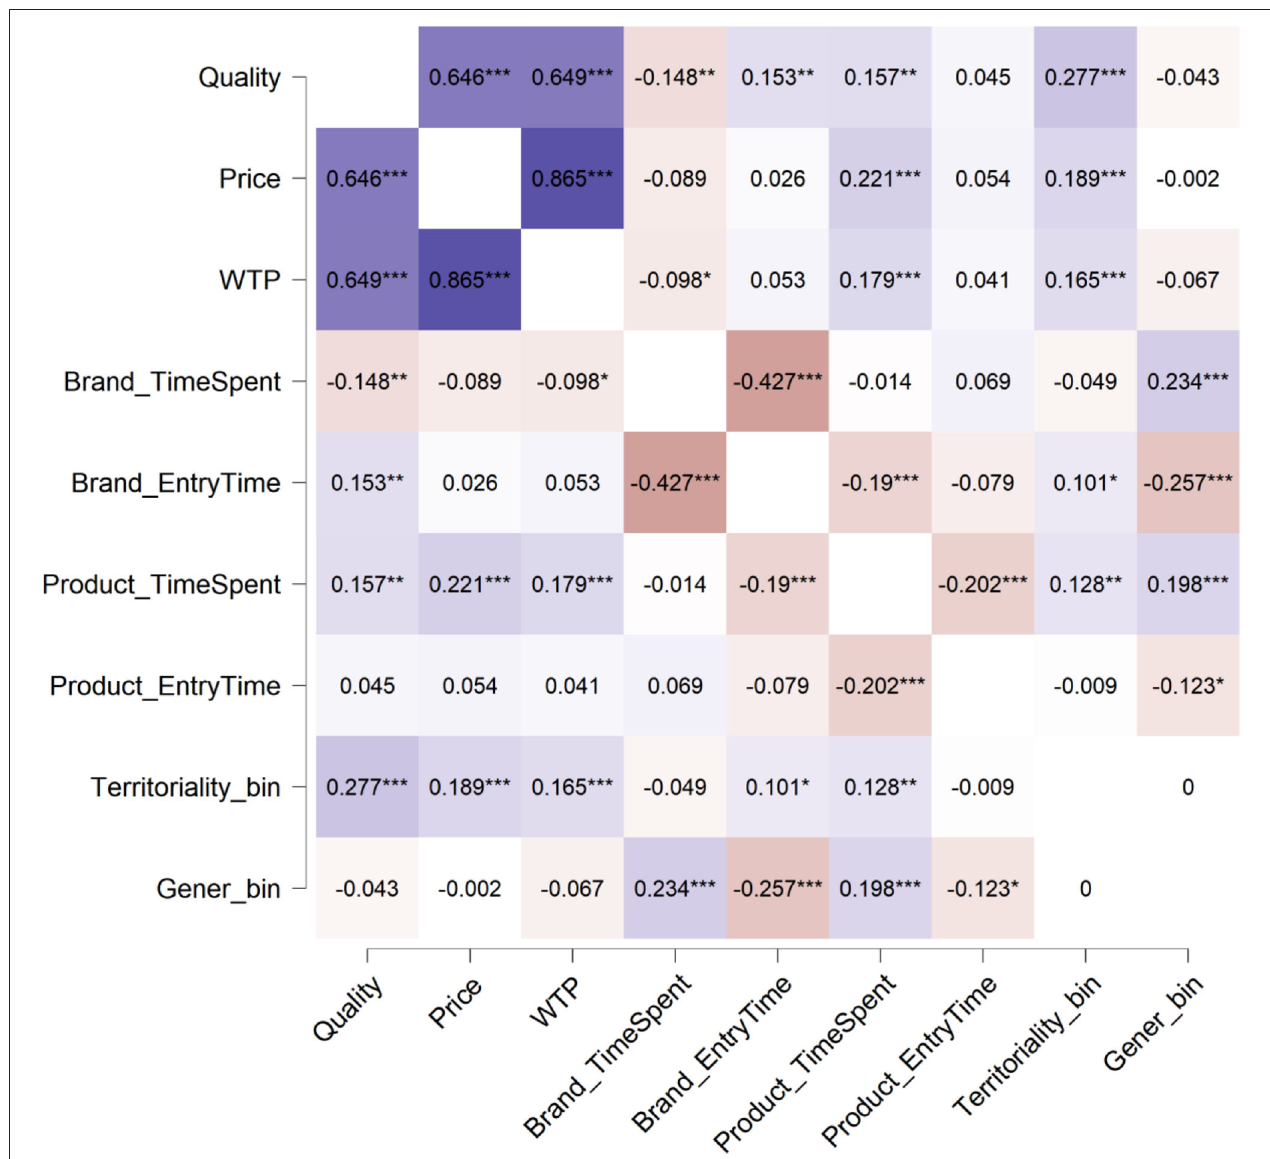
FIGURE 6 | Correlations between variables (non-parametric Spearman coefficient). * p < 0.05, ** p < 0.01, *** p <